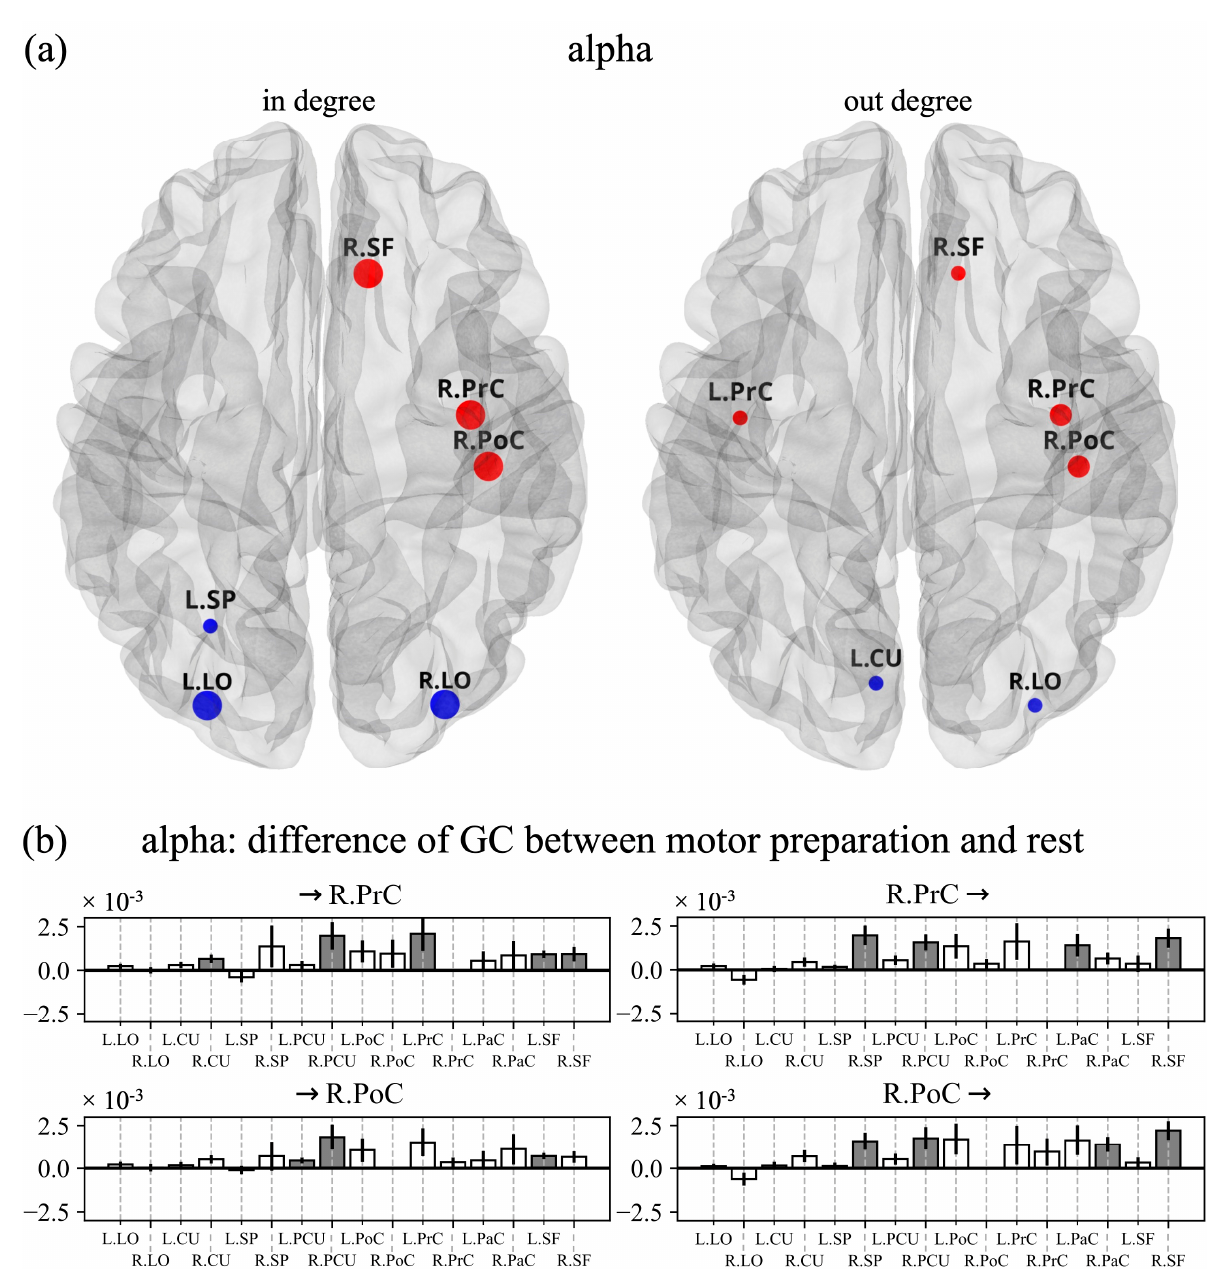
Figure 6. ( a ) ROIs with a significantly different in degree (left panel) and out degree (right panel) during reaching movement preparation compared to rest in the alpha band. Circle size reflects the strength of the significance (small: p < 0.05, medium p < 0.01, large: p < 0.001); red/blue circles denote an increased/decreased measure (in degree or out degree) during movement preparation compared to rest. ( b ) Each bar plot shows, for a selected ROI among the ones in panel a, the difference in the connections (movement preparation—rest) entering in the selected ROI from all other ROIs or exiting from the selected ROIs towards all other ROIs. The bar height denotes the mean value across the subjects and the black line the standard error of the mean. Significant differences are marked via grey bars.